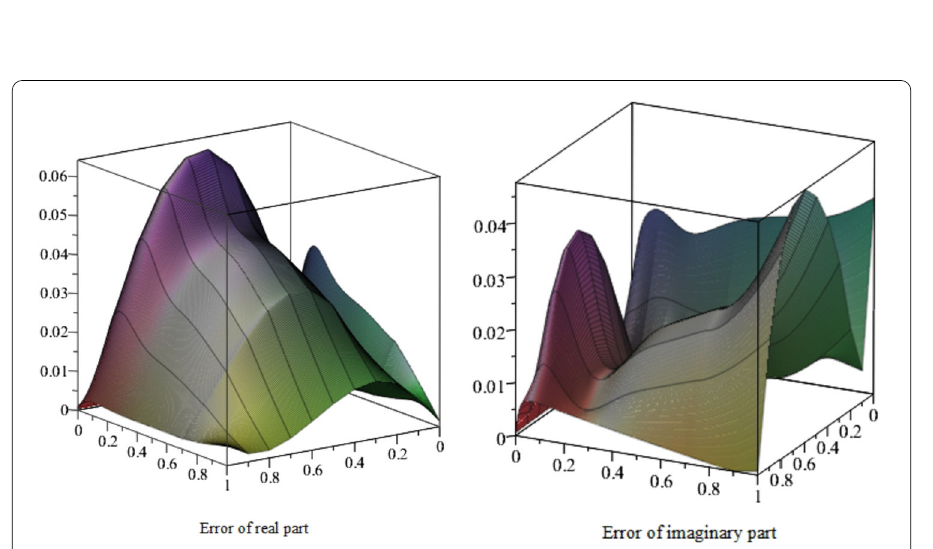
Figure 6 The plots of error of u ( x , t ) and v ( x , t ) for Example 5.2 with the noisy data